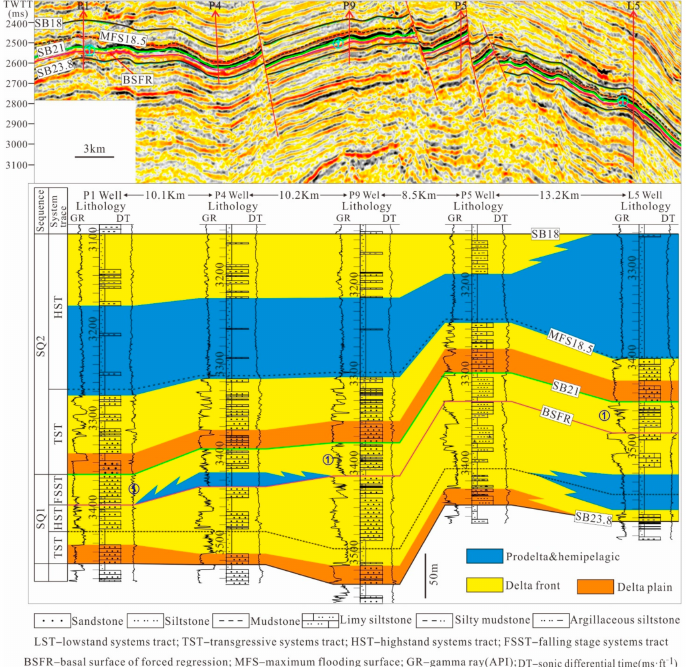
Figure 8. Correlation of wells illustrating the depositional sequences in the Zhujiang Formation of Panyu low uplift and Baiyun sag, Pearl River Mouth Basin (location of section is given in Figure